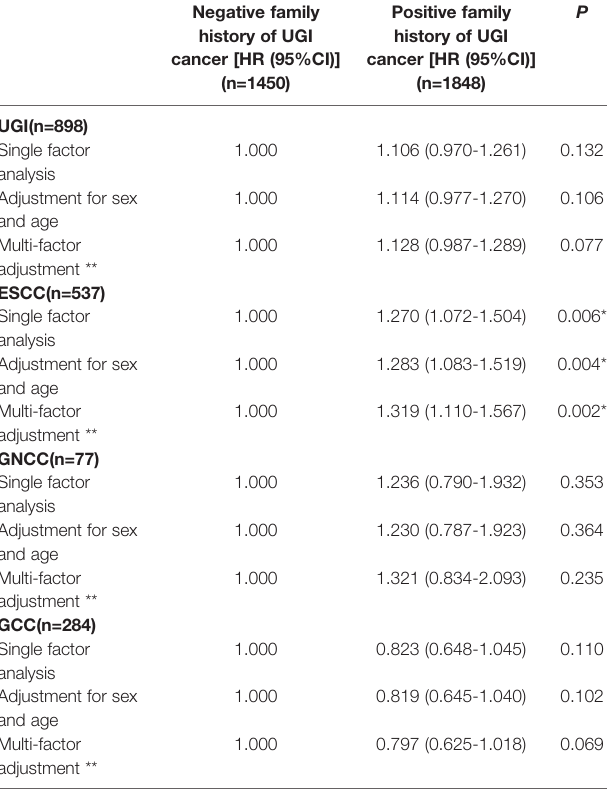
TABLE 2 | The effect of family history of UGI cancer on the risk of death of UGI cancer.